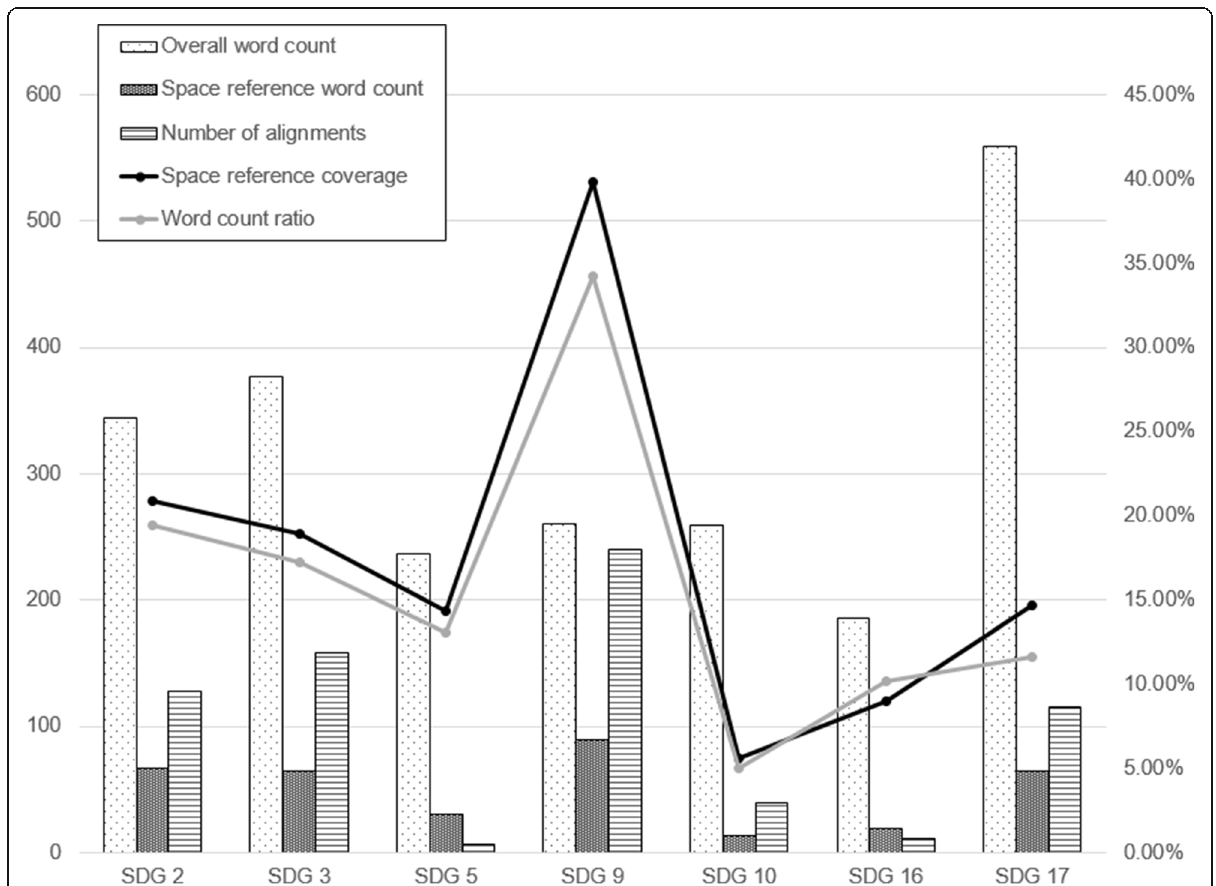
Fig. 11 Percentage of SDG coverage of potential space references in terms of word count. The graph shows the overall word count and potential space reference word count as absolute numbers and ratio, as well as the number of project alignments per SDG